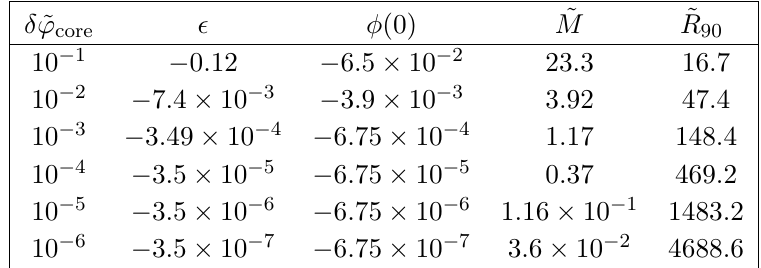
Table 1 . Details of the numerical solutions obtained via the shooting method with the LVS potential, using h ~ ’ i = 14. Notice that for (cid:14) ~ ’ core . 10 (cid:0) 3 the scaling in eq. (3.15) is manifest: as (cid:14) ~ ’ core decreases by a factor of 10, the same happens to (cid:15) and (cid:30) (0), while ~ M decreases by a factor p p of 10 and ~ R 90 increases by a factor of